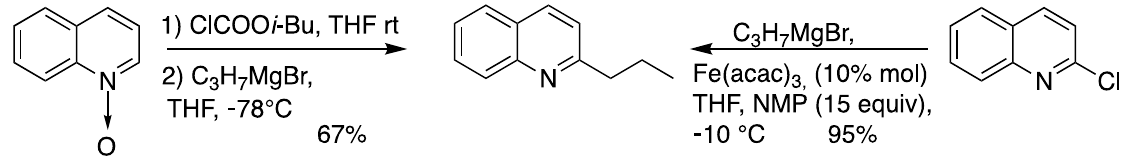
Figure 3. Chemical synthesis of 2 -n- propylquinoline.